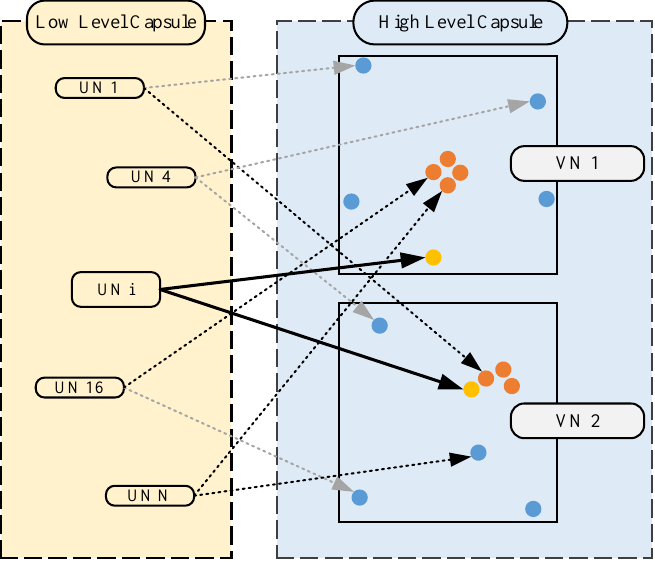
Figure 2. The dynamic routing of the capsule network.